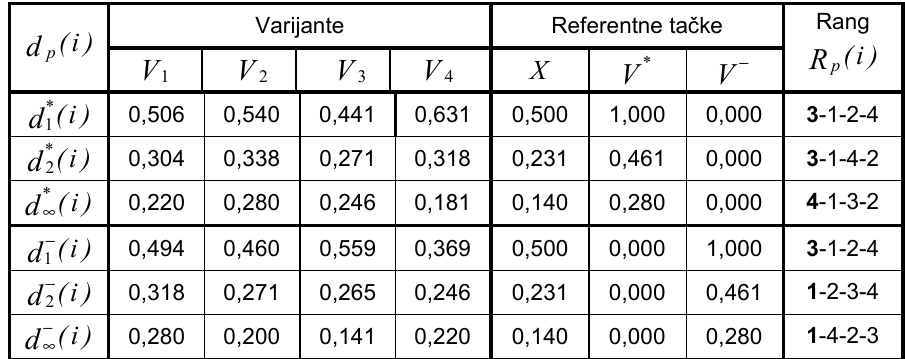
Table 3 – Values of the Lp metrics